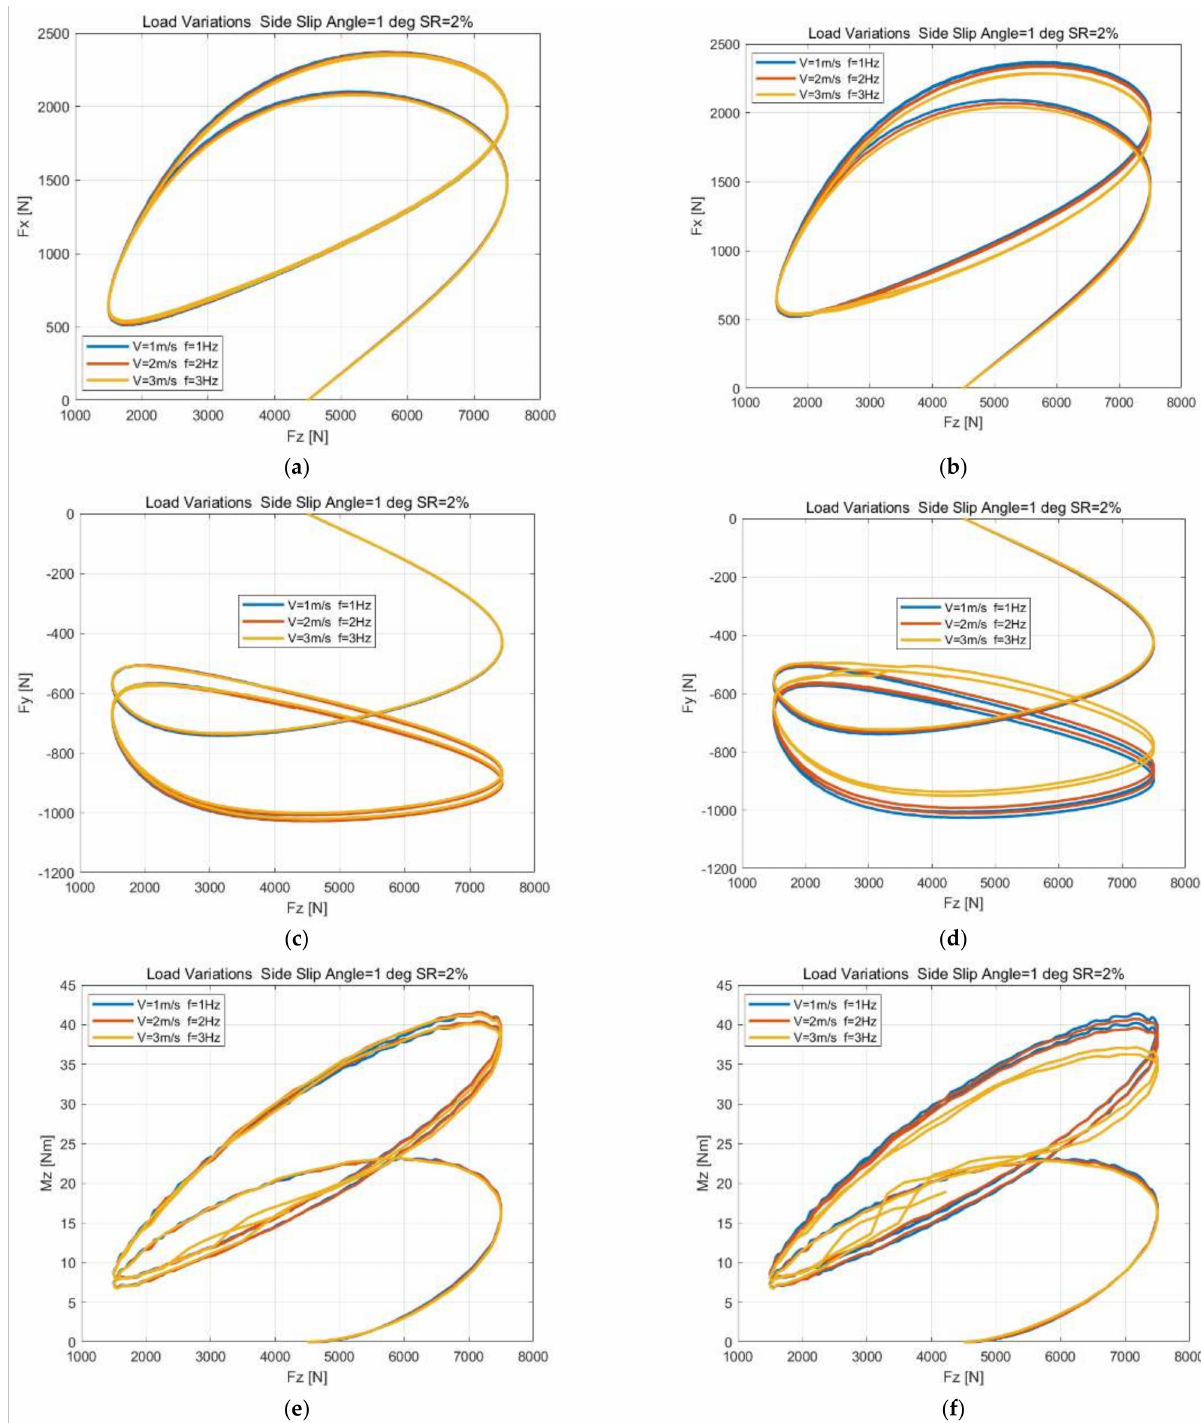
Figure 18. Responses of longitudinal force and lateral force aligning moments under load variations at constant longitudinal and side slip input. ( a ) Response of longitudinal force using the proposed method. ( b ) Response of longitudinal force using the reference method. ( c ) Response of lateral force using the proposed method. ( d ) Response of lateral force using the reference method. ( e ) Re- sponse of aligning moment using the proposed method. ( f ) Response of aligning moment using the reference